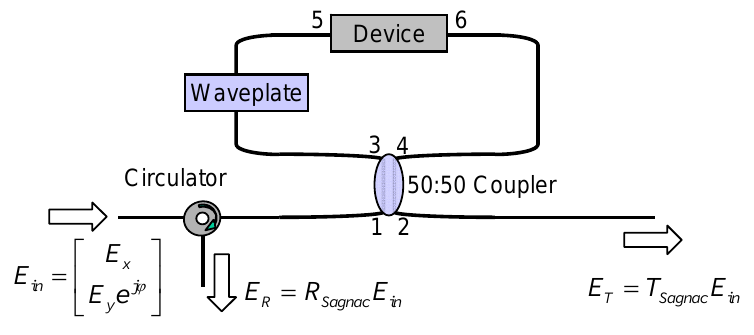
Figure 1. Schematic diagram of the Sagnac interferometer with a polarization-dependent device and a waveplate inside the